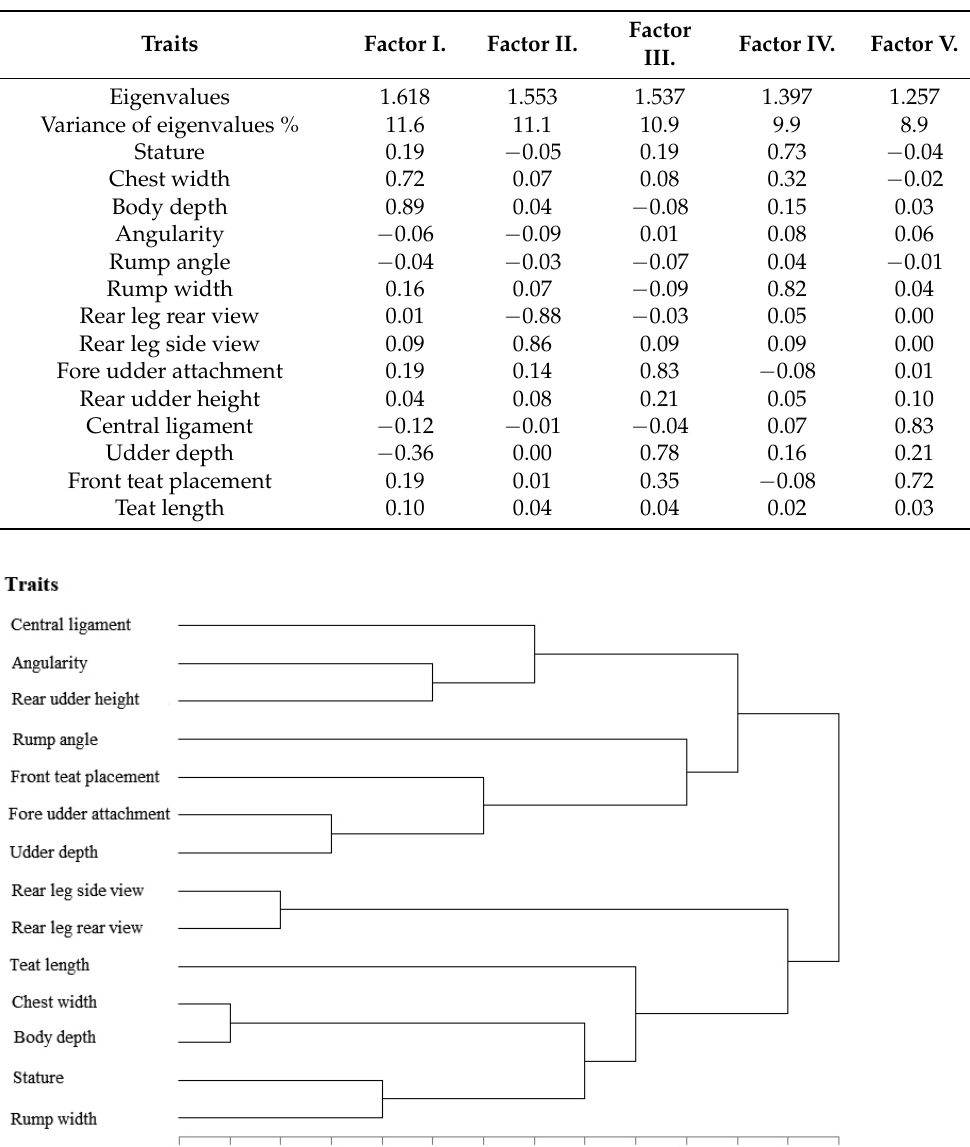
Table 1. Eigenvalues and percentage of the total variance, factors and factor loadings after rotation based on analysis of linear type traits.